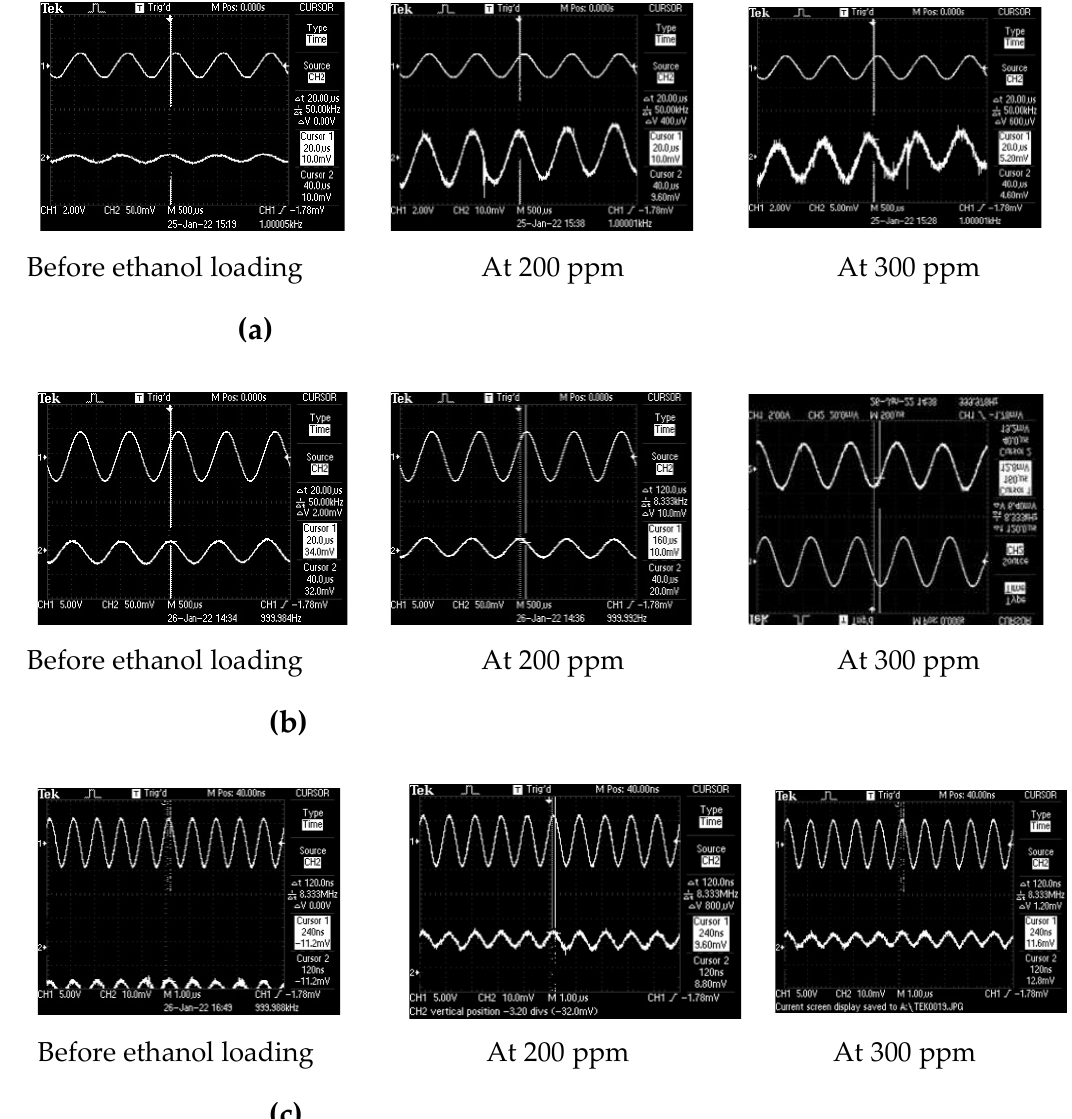
Figure 7. SAW’s output signal shapes and distortions at different ethanol concentrations: ( a ) device 1, ( b ) device 2, and ( c ) device 3.